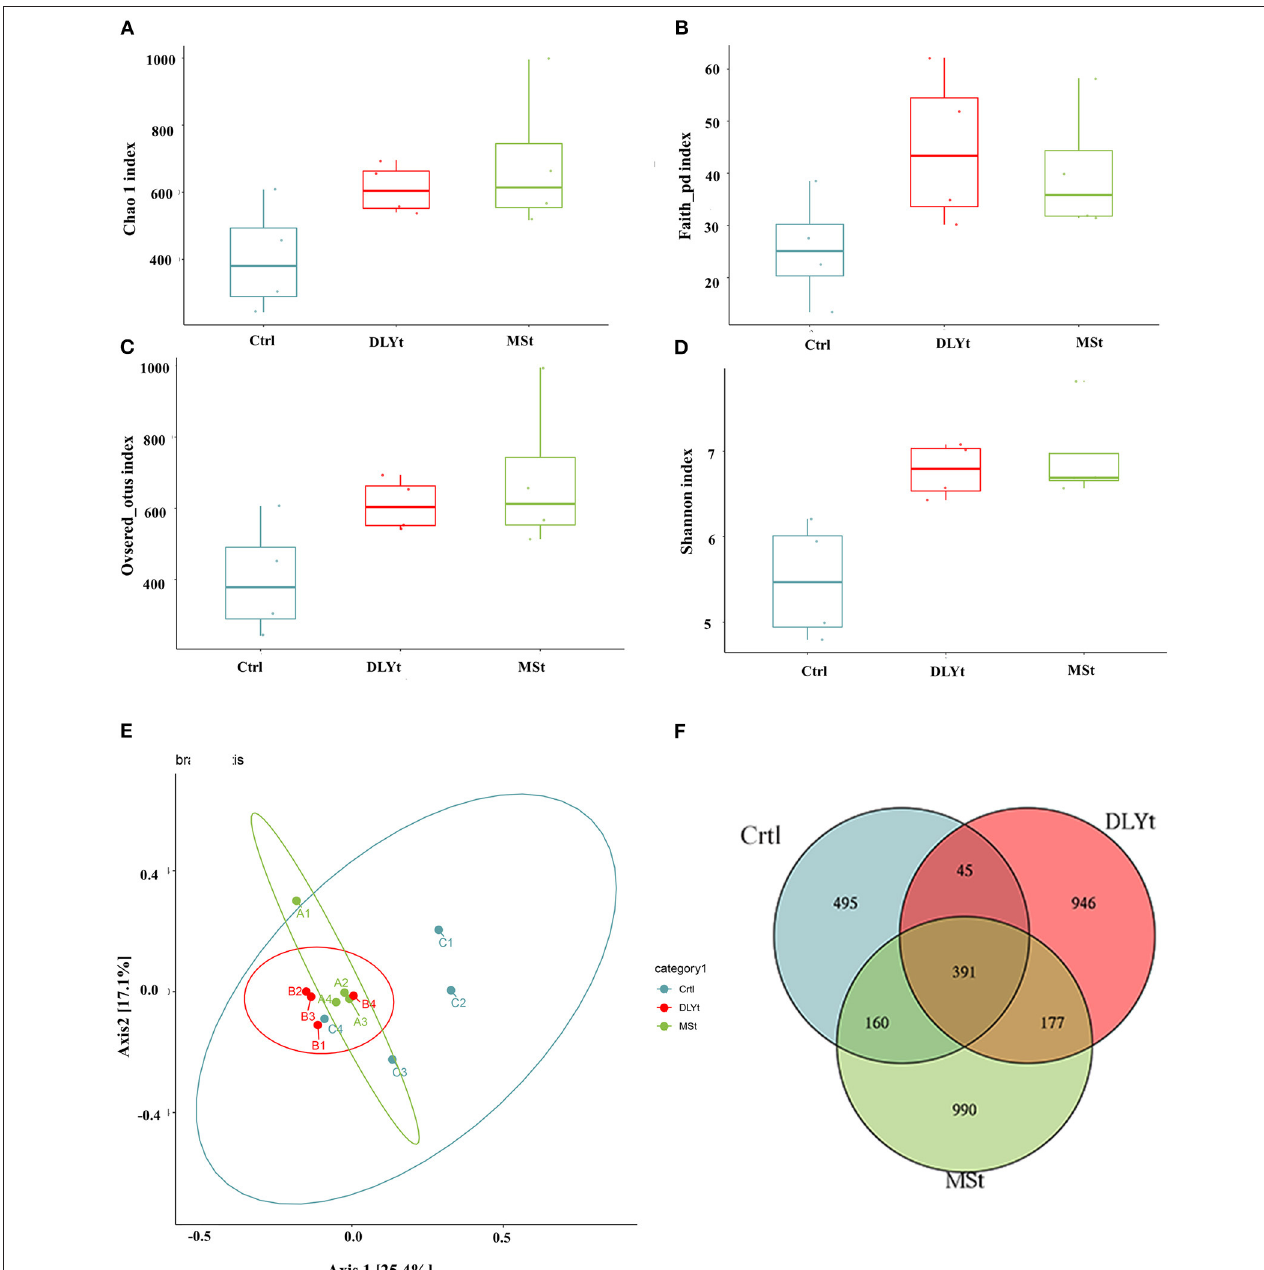
FIGURE 4 | FMT altered the diversity of fecal microbiota ( n = 4/group). (A–D) Analysis results of alpha diversity index (Wilcoxon rank sum test). (E) Principal coordinate analysis plots based on weighted UniFrac distance. Each symbol represents a single sample of fecal contents from the three groups (Welch’s t -test and Wilcoxon rank sum test). (F) Venn diagram of the number of intestinal genera in the fecal samples from the three